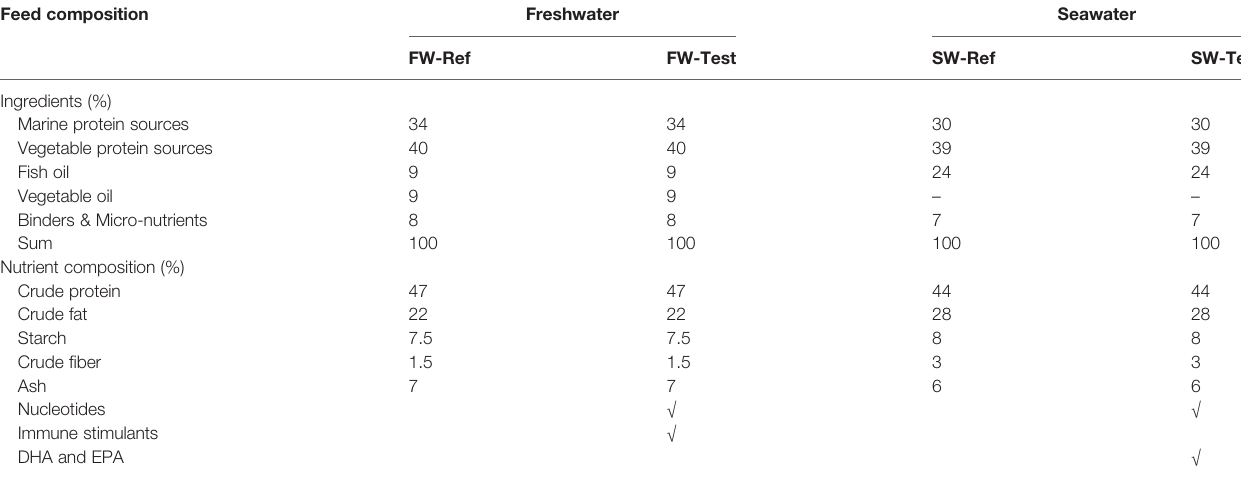
TABLE 1 | Formulation and nutrient composition of Ref and Test diets during freshwater and seawater stages ⁎ . Feed